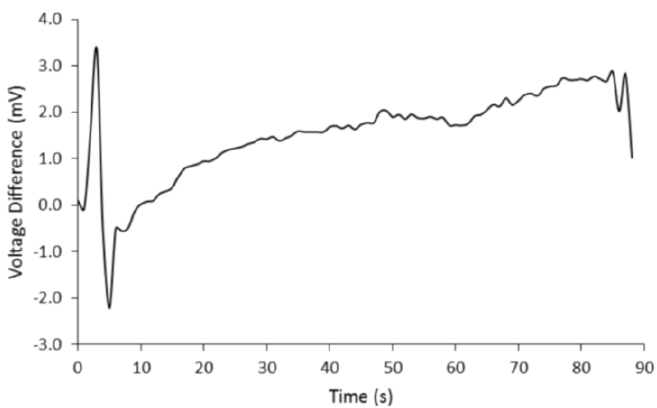
Figure 6. Measured response of a photocell constructed from the bR-PAA transducer when exposed to an 18 mW, 568 nm light